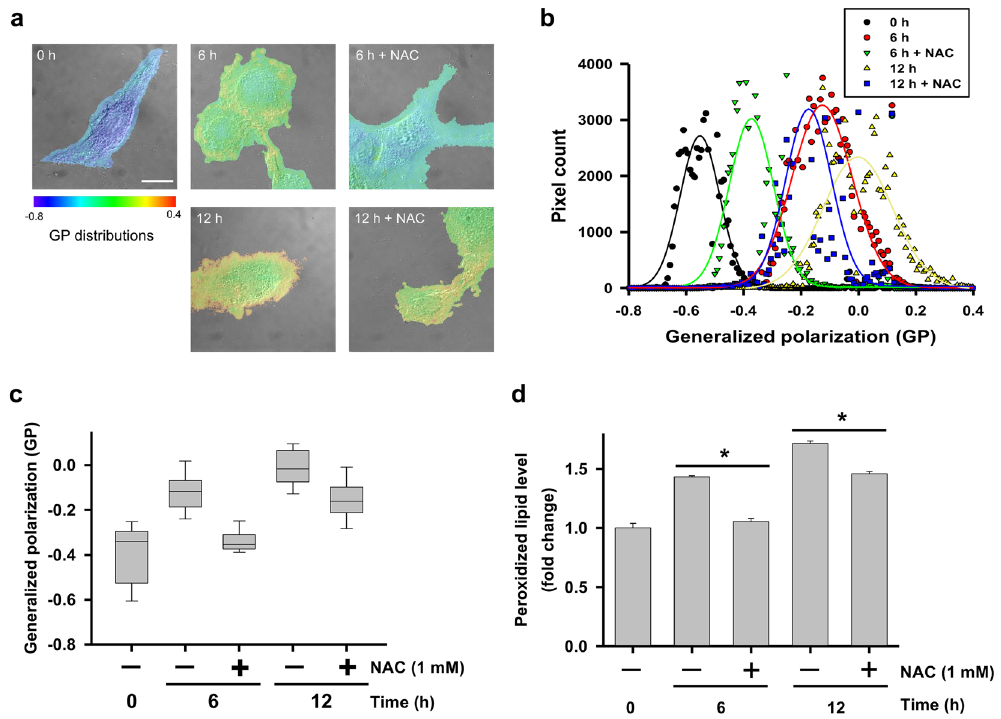
Figure 5. Laurdan GP images, GP frequency distributions, and evaluation of peroxidized lipids in hBM-MSCs stored in PBS for 6 and 12 h. ( a ) Merged DIC and TIRFM images of control hBM-MSCs. GP distributions were ranged from − 0.8 to 0.4. Scale bar = 10 µ m. ( b ) GP frequency distributions of hBM-MSCs. GP values of each pixel are represented as dots and were fitted to Gaussian distributions. ( c ) Total GP values. Data represent the mean ± SD of three independent experiments (n = 10). ( d ) Evaluation of peroxidized lipids using ferrous thiocyanate. The intensity of non-peroxidized lipid was used as a blank. Data represent mean ± SD of three independent experiments. * P <